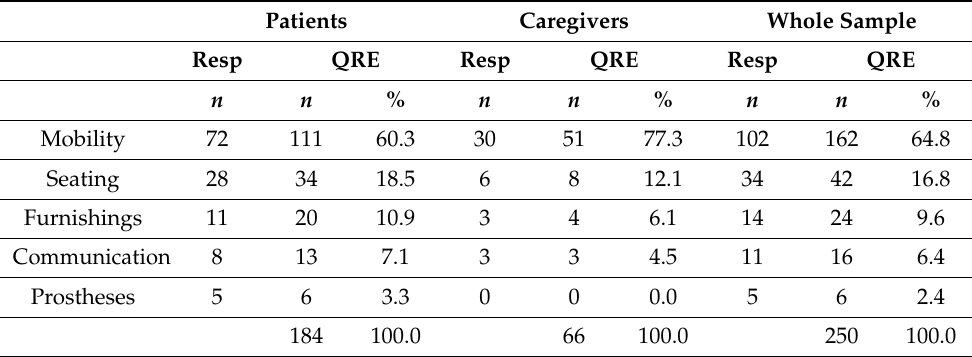
Table 1. Number of respondents and questionnaires for each class of assistive